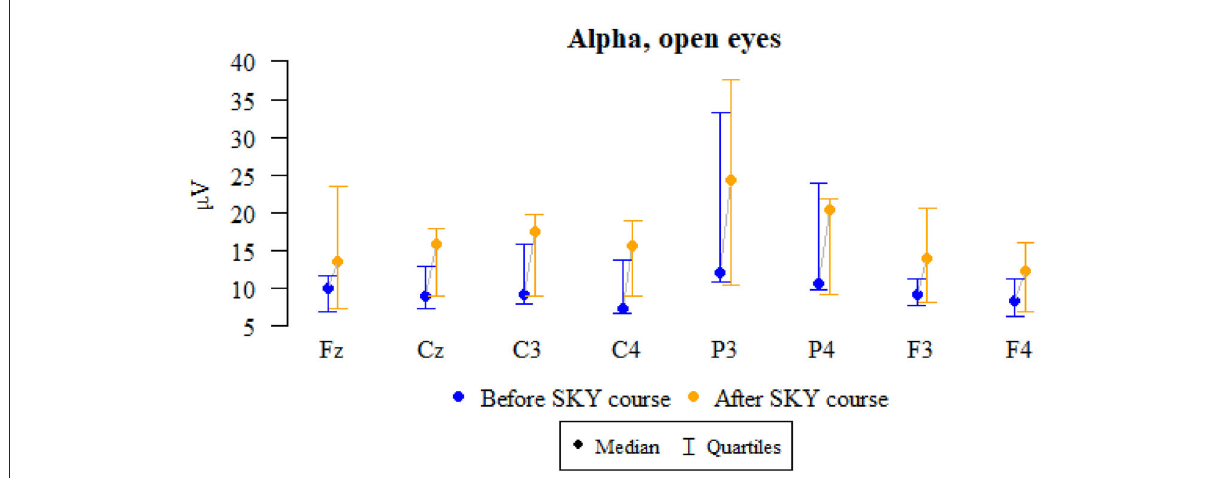
FIGURE1 Graphical comparison of Alpha wave amplitudes before the SKY course (the first day) and after the whole SKY course (third day) with eyes open.